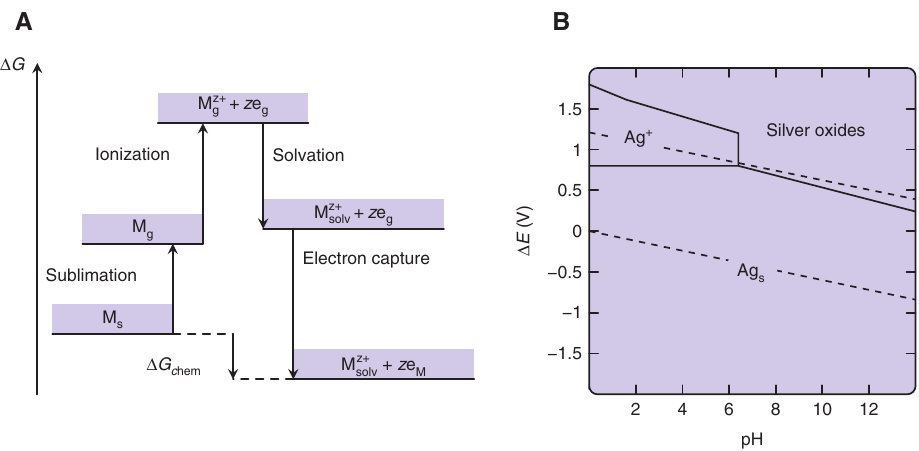
Figure 1: Contributions to the reduction potential. (A) Thermodynamic Born-Haber cycle: transfer of a metal ion from the metal to the electrolyte [30]. Various contributions to the free enthalpy change and thus to the reduction potential of a substance need to be considered when designing an electrolyte. (B) Simplified Pourbaix diagram for the silver/water system [31], visualizing conditions for thermodynamically stable phases and phase transitions. Dashed lines represent the upper and lower boundaries for stable